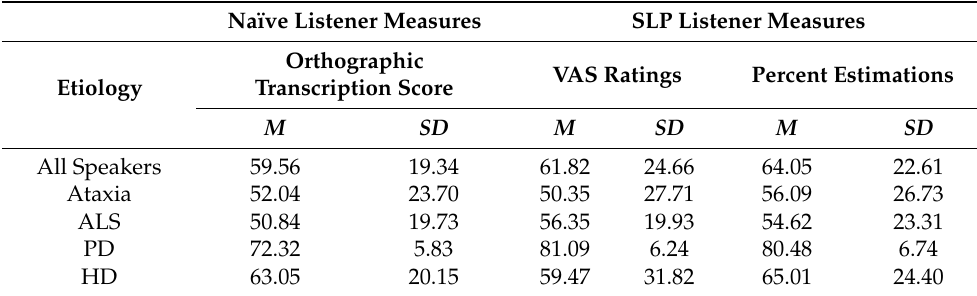
Table 2. Descriptive Statistics for the Three Intelligibility Measures.